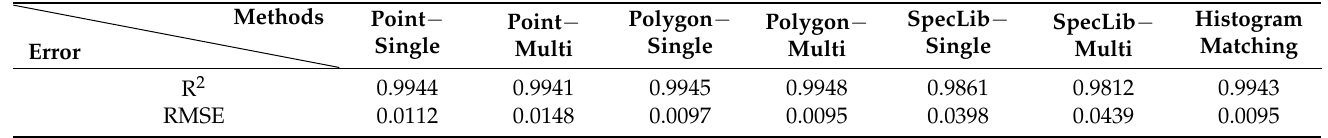
Figure 8. R 2 and RMSE of image consistency at each pixel. Note, to present the pixel − wise values, the minimum and maximum of R2 maps range from 0.9950 to 1, and RMSE maps range from 0 to 0.1. Table 5. The mean R 2 and RMSE of image consistency at each pixel. To quantitatively present accuracy, we computed the mean value of each